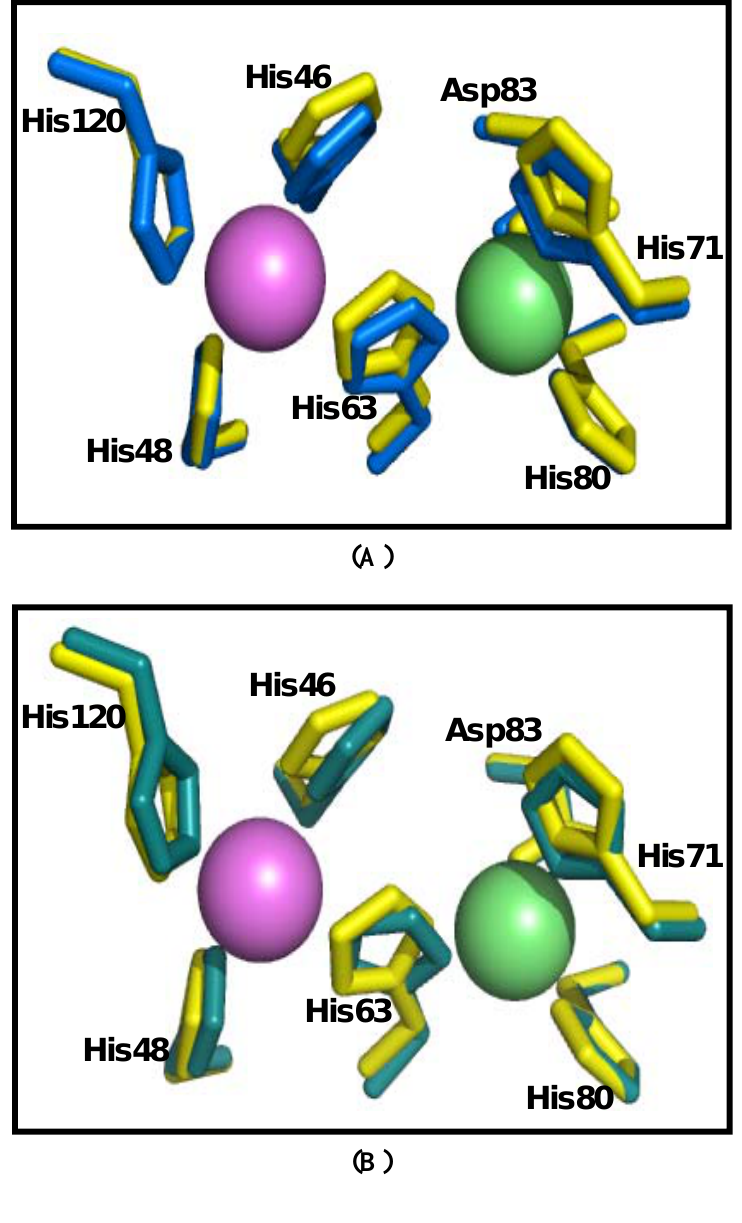
Figure 8. Comparison of the cSOD1 active site residues of Camelus dromedarius (yellow) with Homo sapiens (blue) ( A ) and Bos taurus (deepteal) ( B ). Copper is shown in purple and zinc green color. The active site of the SOD1 from the three organisms contains the highly conserved His and Asp residues. Copper is liganded with four histidines (His 46, 48, 63 and 120) and zinc is liganded with three histidines and one aspartic (His 63, 71, 80 and Asp 83). The residues are numbered according to amino acid sequence of Camelus dromedarius (accession number JF758876). This comparison indicated very high similarity between the predicted active site of cSOD1 and that of hSOD1 and